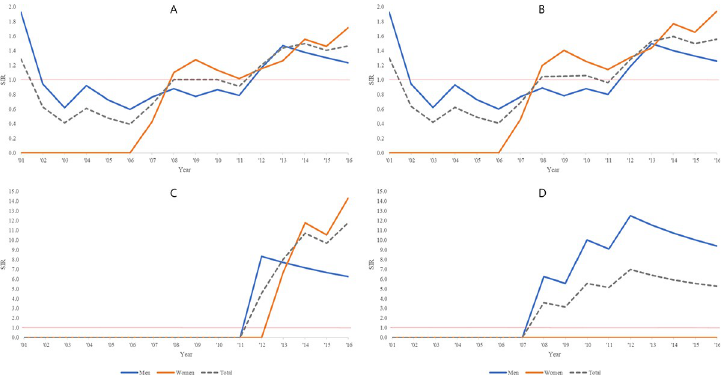
Fig 4. The cumulative cancer standardized incidence ratio by year of the Jang-jeom village compared to the whole of Korea in 2010–16. A) All cancers (C00-96), B) All cancers except thyroid cancer (C00-72, 74–96), C) Skin cancer except melanoma (C44), and D) Gallbladder and biliary cancer (C23, C24).